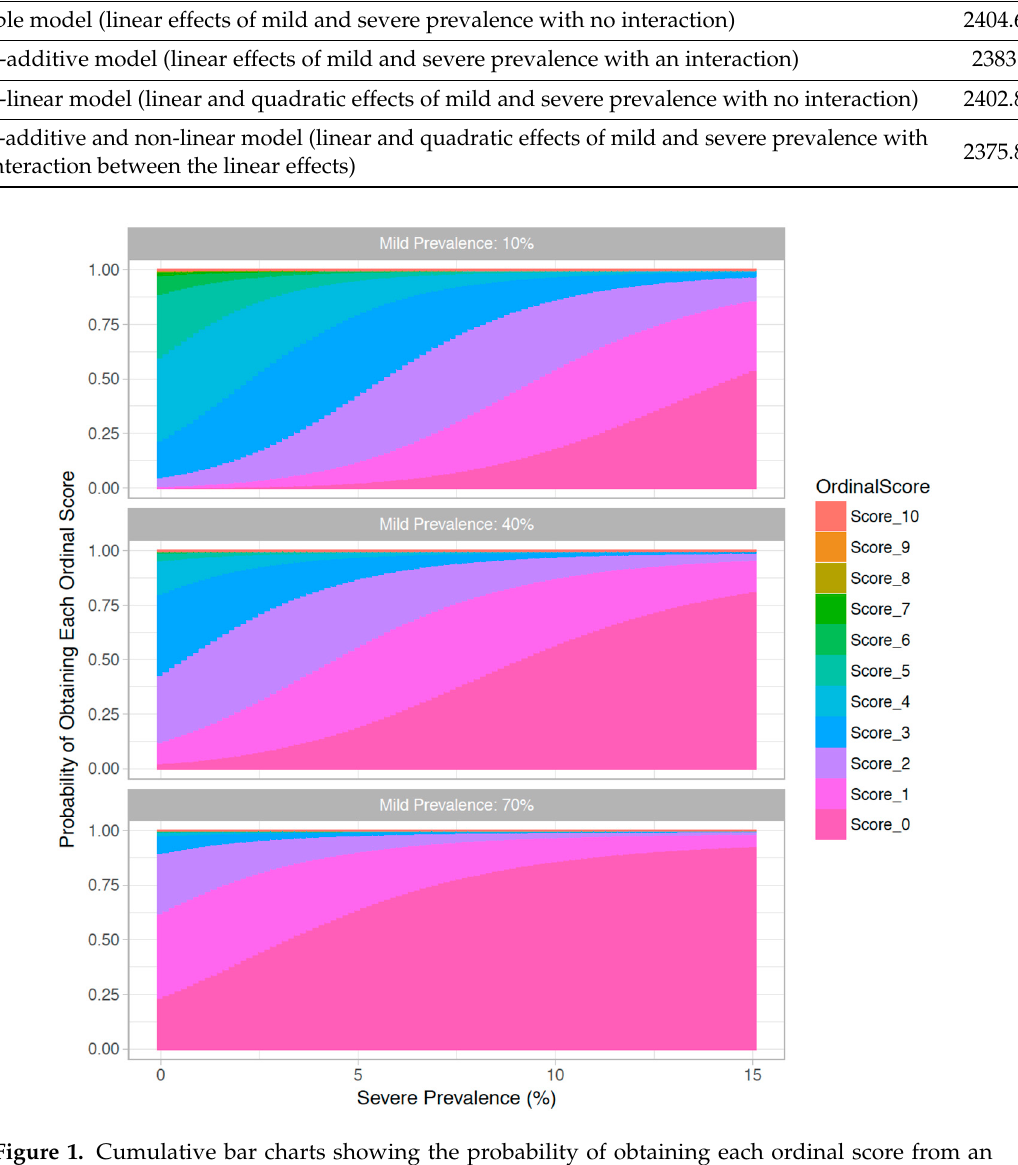
Figure 1. Cumulative bar charts showing the probability of obtaining each ordinal score from an “average” expert ( y axis), given an increasing severe prevalence ( x axis) and different levels of mild prevalence (sub-plots). Probabilities are based on a cumulative link mixed model.